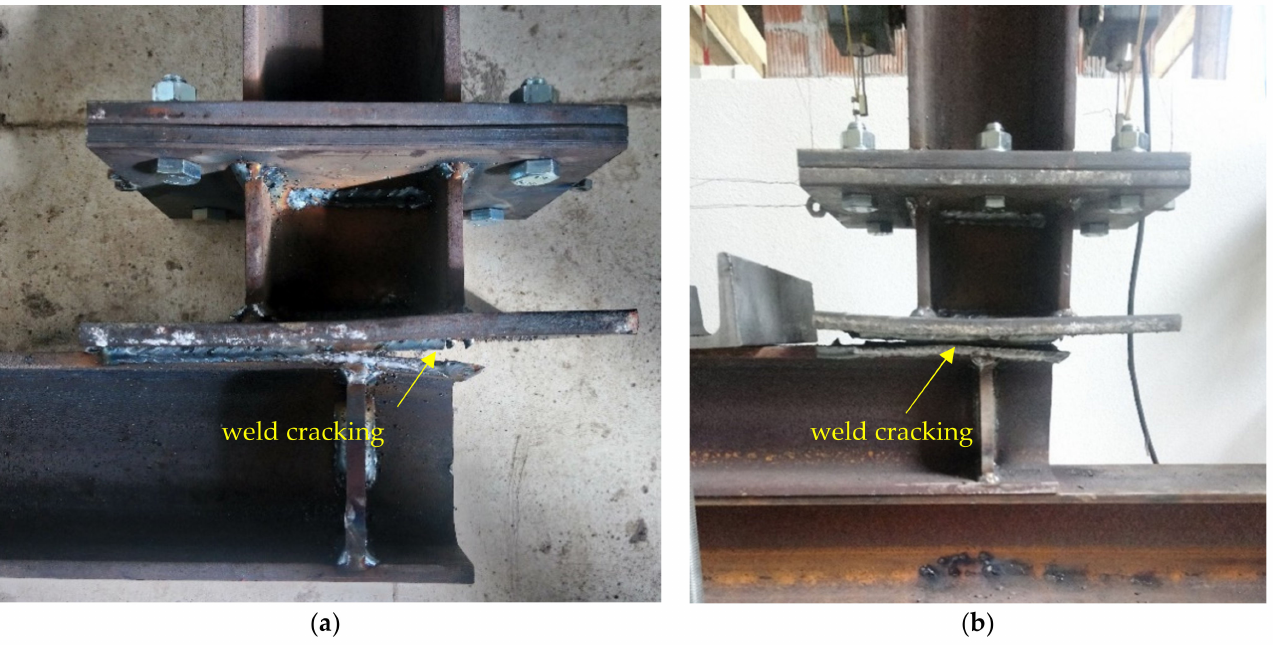
Figure 16. Failure mechanism of the steel bolted joint specimens: ( a ) JL-4 specimen and ( b ) JL-6 specimen.